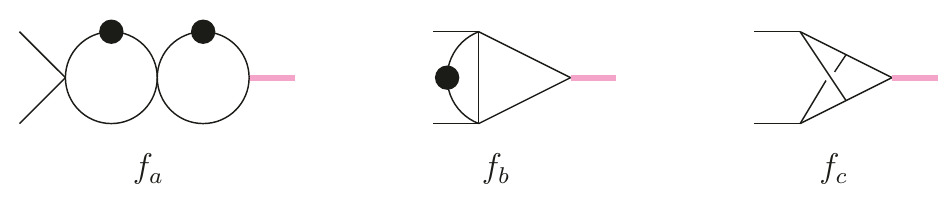
Figure 4. Three MIs for mixed QCD-QED two-loop virtual corrections to q ¯ q 0 → W ∗ .